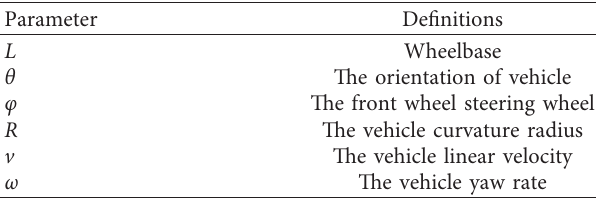
Algorithm 3 Improved Bi-RRT Algorithm